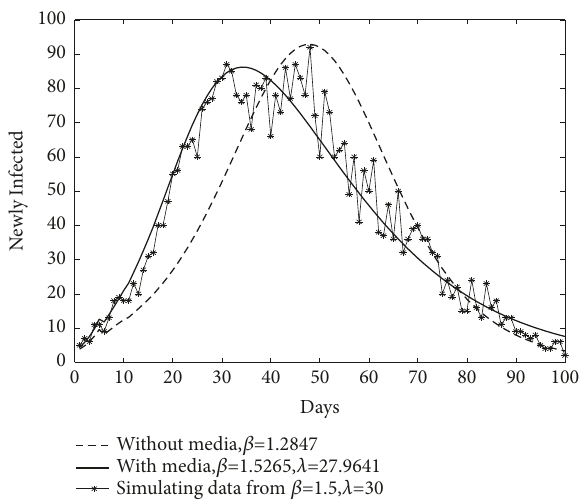
Figure 4: Different estimations on the same data produced by a model with media coverage where 𝛽 = 1.5 and 𝜆 = 30,𝑃 𝜏 = 1/5 (1 ≤ 𝜏 ≤ 5), 𝑖(𝑡) = 0 (−4 ≤ 𝜏 ≤ −1),𝑖(0) = 15, 𝑆(−5) = 10 5 . The solid line corresponds to the estimated model with media coverage (the ̂𝛽 = 1.5265 ̂𝜆 = 27 estimates are and ). The dash line corresponds to the estimated model without media coverage (the estimate is ̂𝛽 = 1.2847 ).